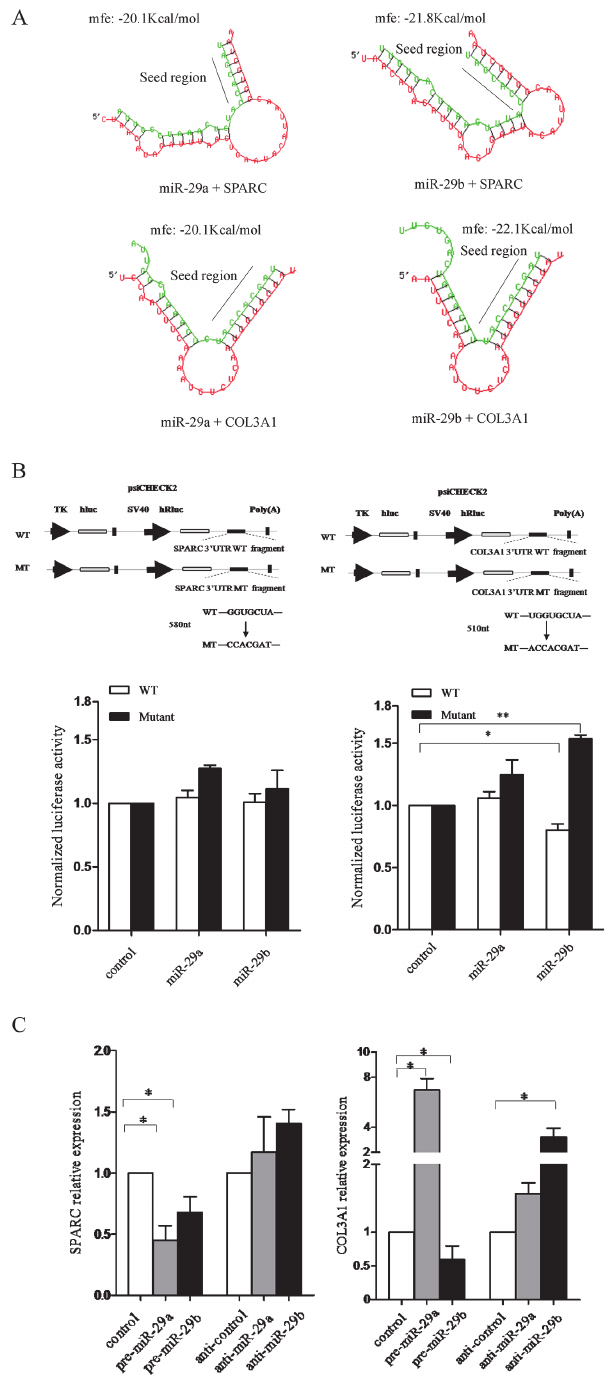
Fig 2. Identification of SPARC and COL3A1 as miR-29a/b targets. (A) Conserved miR-29a/b binding sites in the 3 0 -UTRs of SPARC and COL3A1 are predicted by TargetScan; candidates were filtered using a hybridization free-energy threshold of − 19.0 (kcal/mol).The sequences in green refer to miRNA, and the sequences in red refer to the 3 0 -UTR of mRNA. (B) A schematic diagram showing the 3 0 -UTR reporter constructs. The sequences of the wild type or mutant site in the 3 0 -UTR fragments are shown. MT: Nucleotide substitutions disrupting the miRNA-29a/b-binding sites were introduced in the 3 0 UTRs of SPARC and COL3A1 cloned downstream of the Renilla luciferase gene. (C) Luciferase activities were measured 48 h after transfection with plasmids pEGFP-miR-29a/b and their mutants. The activities of Renilla luciferase